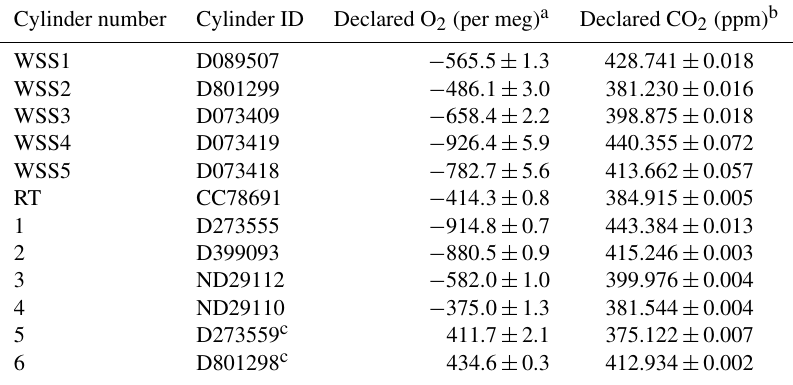
Table 1. Declared O 2 / N 2 ratios and CO 2 mole fractions with ± 1 σ standard deviations of the five WSSes, RT, and six “unknown” cylinder gases used in the CRAM Laboratory tests of the G2207- i